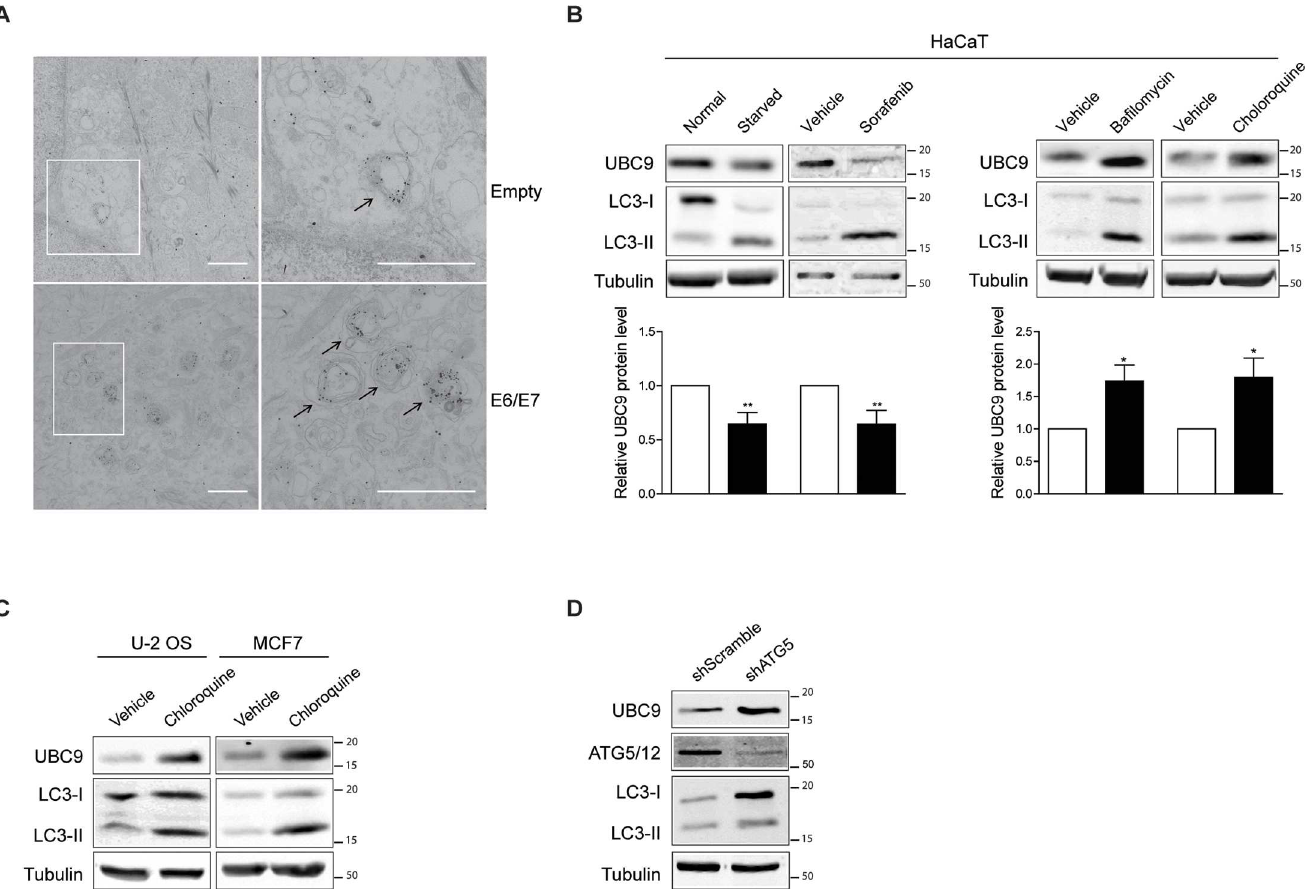
Fig 7. UBC9 is degraded by autophagy in epithelial cells. (A) Immunolocalizationof UBC9 in ultrathinsectionsof HKs transducedwith empty or HPV16 E6/E7 vectors. Originalview (left) and highermagnification (right) of boxedregions. Gold particlesare selectively enriched in autophagicstructures highlighted by arrows. Scale bar = 1 μ m. (B) Top: Representative WB of HaCaT cells treated with the indicatedautophagicactivators (left) and inhibitors (right). Activation of autophagywas monitored by the conversion of LC3 (LC3-I) to the lipidatedLC3 (LC3-II) form, a marker of autophagosome production inducedby autophagic stimuli [41].LC3-II accumulation was used to verify autophagicimpairment [41].Bottom: normalizedUBC9 expression.Data are expressed as fold over untreated cells. Bars representmeans ± SEM of n = 4 differentbiologicalreplicates. ns: not significant(Kruskal–Wallisone-way ANOVA with Dunn’spost hoc test) comparedto vehiclecontrol groups.( C) Representative WB analysisof U-2 OS or MCF7 cells treated with chloroquine. n = 3 different biologicalreplicates. (D) Representative WB analysisof MCF7 cells transduced with scrambleor ATG5 shRNA. The observedATG5 band represents the ATG5-ATG12 conjugated form. LC3-I accumulation is reportedto evidenceautophagic deficiencies promotedby shATG5. n = 3 replicates of a